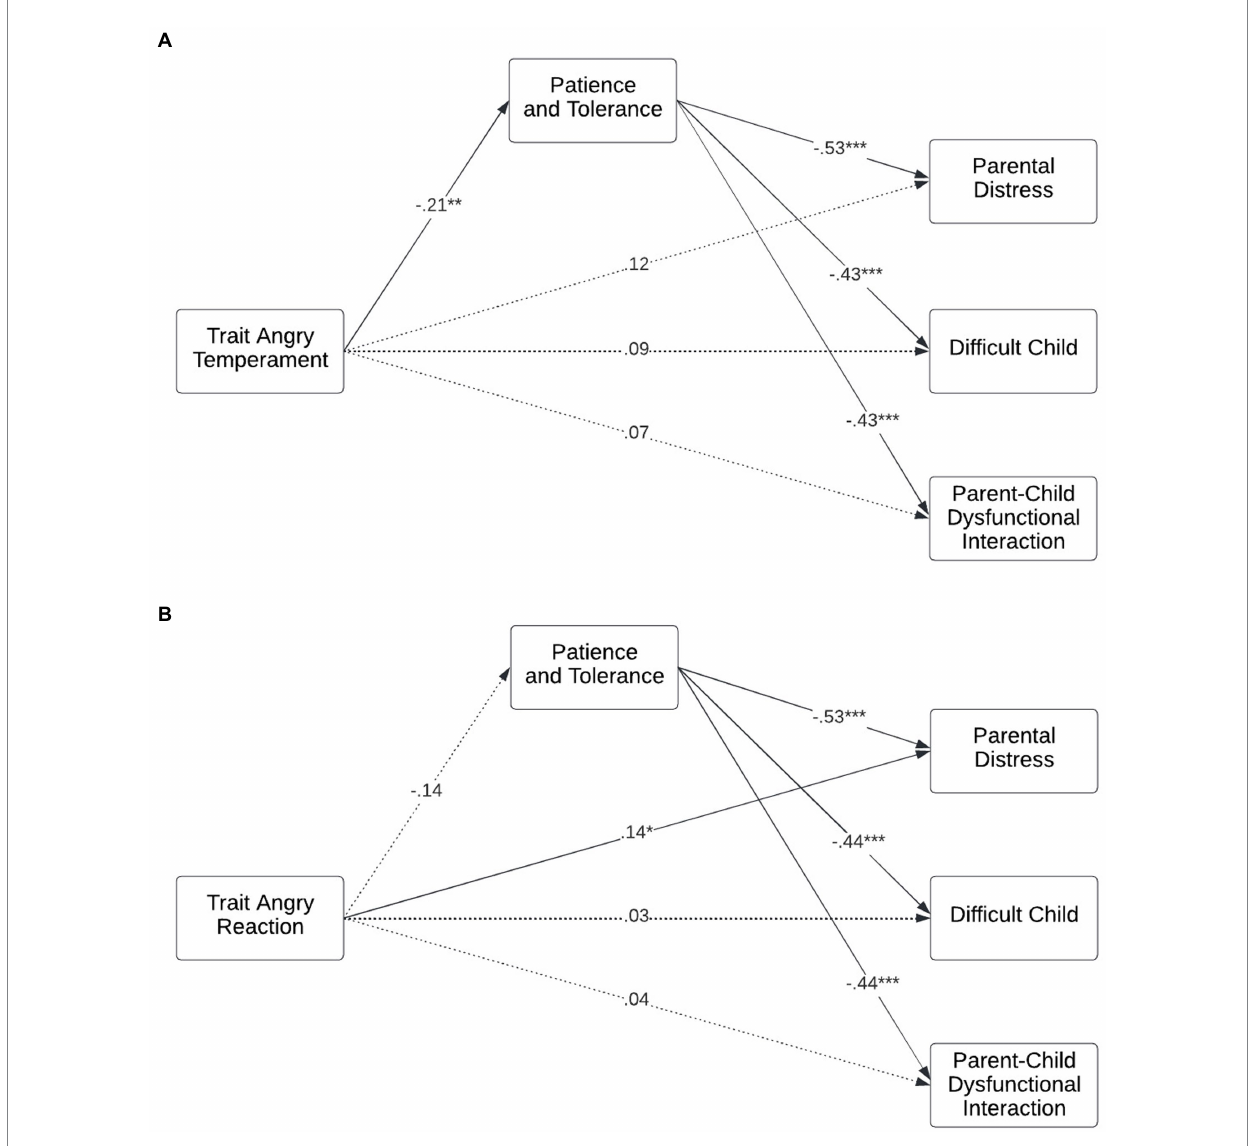
FIGURE 2 Father trait angry temperament (A) and trait angry reaction (B) on parenting stress in the toddler years, through patience and tolerance in the father– infant bond. All effects are standardized. Models are adjusted for covariates. n = 177 fathers of 205 children. Cluster robust standard error estimators were used to account for the clustered nature of the data, i.e., fathers with multiple children. Dotted line indicates non-significant paths. * p < 0.05, ** p < 0.01, *** p <